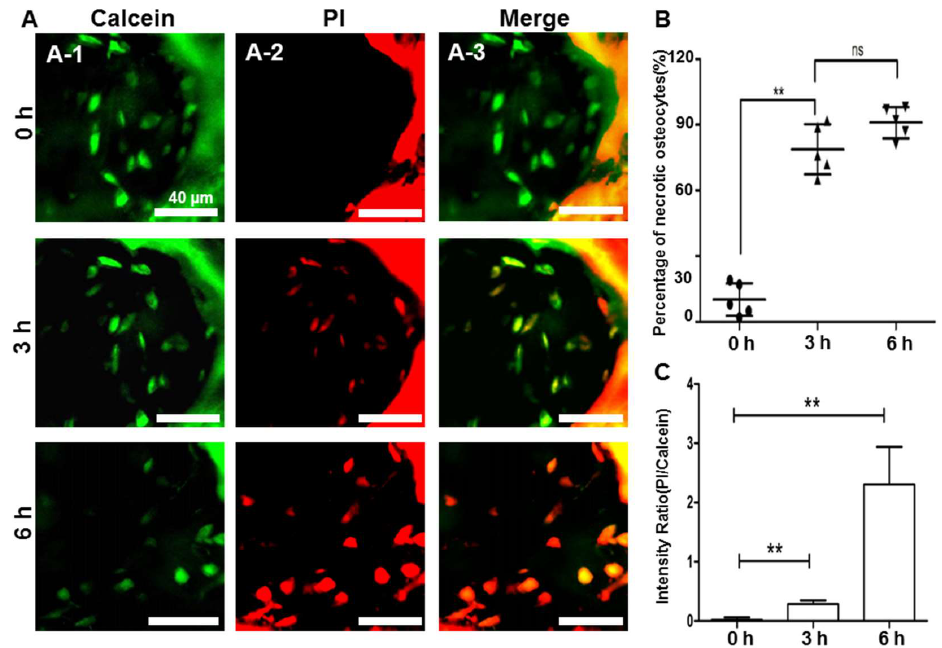
Figure 4. The changes of osteocytes after photo-thrombosis: ( A ) Osteocytes before they were stained with Calcein and PI at 0h 3h and 6h after photo-thrombosis; ( B ) Percentage of dead osteocytes; ( C ) The intensity ratio of PI/Calcein. ** p < 0.01, by a two-tailed unpaired t -test; ns, not significant.